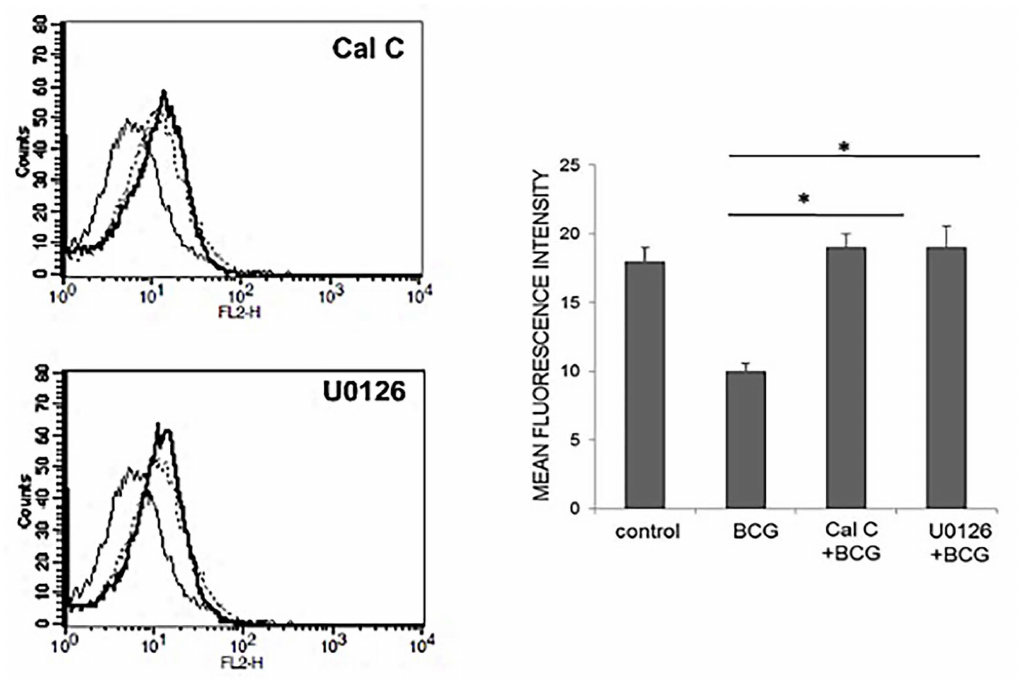
Figure 3: PKC and MAPK-ERK regulate M. bovis BCG mediated IFN-γR expression on macrophages. THP-1 derived macrophages were treated with specific bio-pharmacological inhibitors to PKC (Calphostin C; Cal C, 0.1µM) and ERK-MAPK (U0126, 10µM) for 1h prior to infection with M. bovis BCG at 2MOI for 24h. IFN-γR levels were monitored by flow cytometry. *p<0.05, using one-way ANOVA with Tukey’s correction